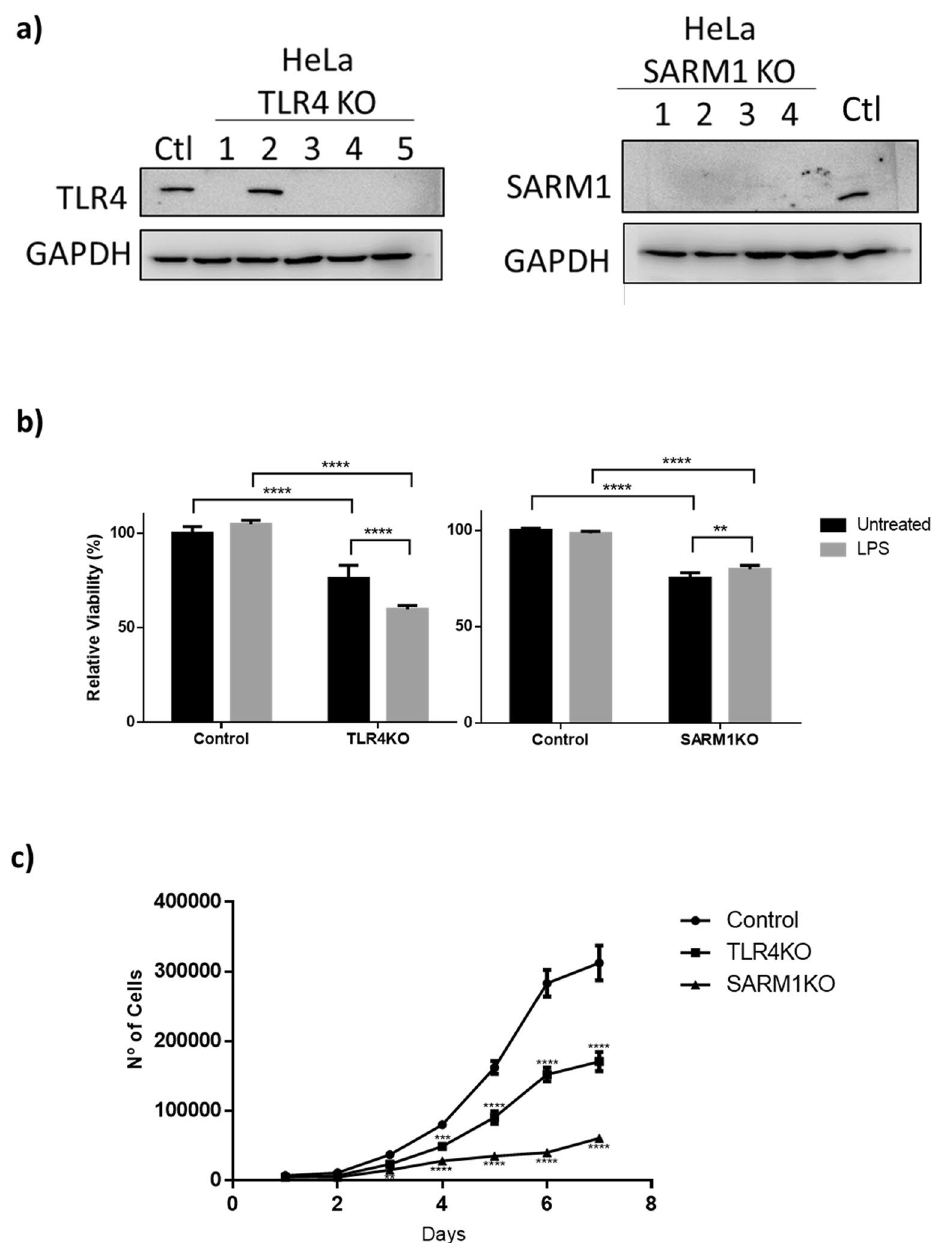
Figure 1. Knockout of TLR4 or SARM1 decreases proliferation and viability of HeLa cells. ( a ) TLR4 and SARM1 protein expression after gene editing. TLR4KO clone 5 and SARM1KO clone 3 were selected for further analysis. ( b ) Cell viability of clones of HeLa cells after TLR4 and SARM1 knockout. Cells were seeded in 96 well-plates, treated with LPS for 48 h and analyzed using PrestoBlue reagent assay. ( c ) Proliferation of TLR4KO, SARM1KO and parental HeLa cells. Cells were seeded in 24-well plates and counted daily in triplicates for 7 days. Data in B and C displayed as mean ± SD. (**p ≤ 0.01; ***p ≤ 0.001; ****p ≤